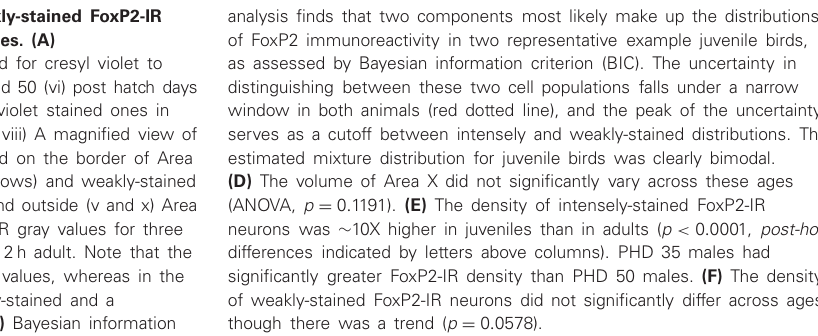
analysis finds that two components most likely make up the distributions of FoxP2 immunoreactivity in two representative example juvenile birds, as assessed by Bayesian information criterion (BIC). The uncertainty in distinguishing between these two cell populations falls under a narrow window in both animals (red dotted line), and the peak of the uncertainty serves as a cutoff between intensely and weakly-stained distributions. The estimated mixture distribution for juvenile birds was clearly bimodal. (D) The volume of Area X did not significantly vary across these ages (ANOVA, p = 0 . 1191). (E) The density of intensely-stained FoxP2-IR neurons was ∼ 10X higher in juveniles than in adults ( p < 0 . 0001, post-hoc differences indicated by letters above columns). PHD 35 males had significantly greater FoxP2-IR density than PHD 50 males. (F) The density of weakly-stained FoxP2-IR neurons did not significantly differ across ages, though there was a trend ( p = 0 .